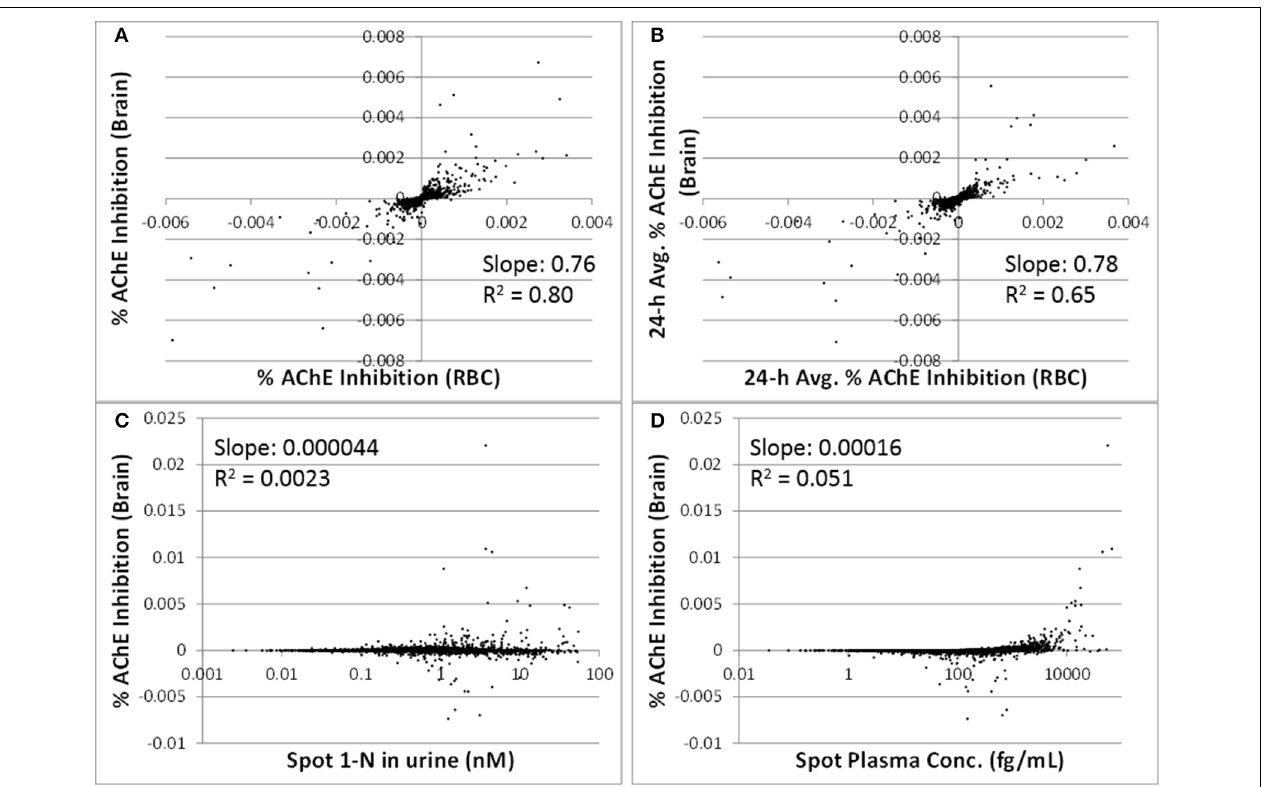
FIGURE 5 | Utility of peripheral markers to predict inhibition in the target tissue (brain) for 5000 simulations. (A) Spot percent AChE inhibition in the brain vs. spot percent AChE inhibition in red blood cells, taken at the same time as the urine sampling; (B) 24-h averaged AChE inhibition in brain